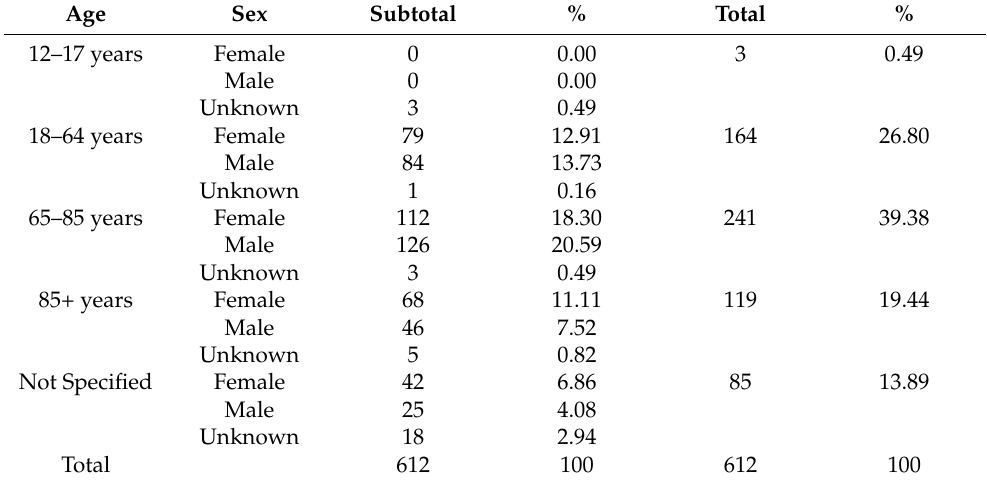
Table 1. Patients’ age and sex who expressed at least one adverse event related to molnupiravir.